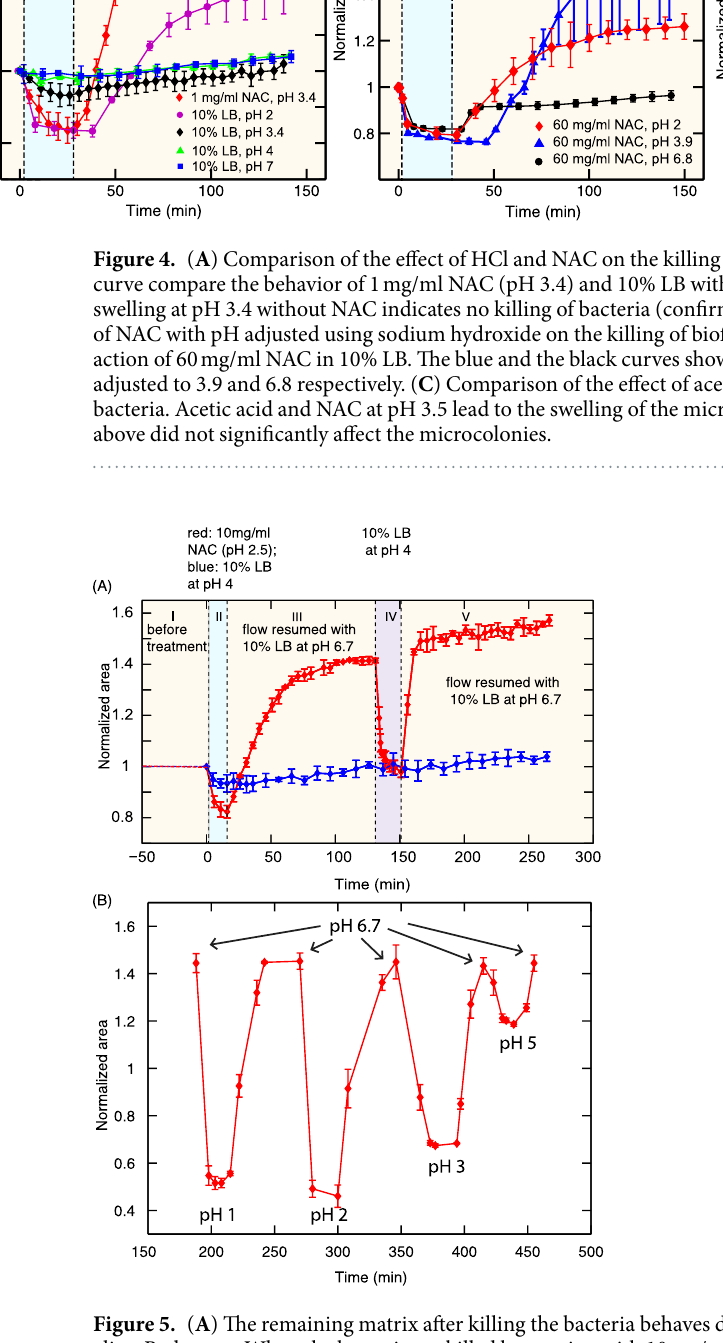
Figure 5. ( A ) The remaining matrix after killing the bacteria behaves differently than when the bacteria are alive. Red curve: When the bacteria are killed by treating with 10 mg/ml NAC (region II), the microcolonies swelled on returning the pH back to 6.7 (region III). The microcolony again shrank on treating with 10% LB at pH 4 (region IV) and swelled with in a shorter time when the pH was switched back to 6.7. Blue curve: The microcolonies did not respond to the changes in pH when the bacteria are not killed in region II. ( B ) The remnant matrix after the bacteria are killed behaved as a pH switchable polyelectrolyte hydrogel - shrinking and swelling reversibly when the pH was switched between a low and high